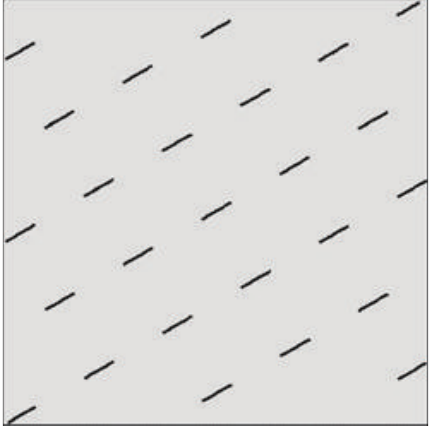
Figure 3: Sketch map of the precrack